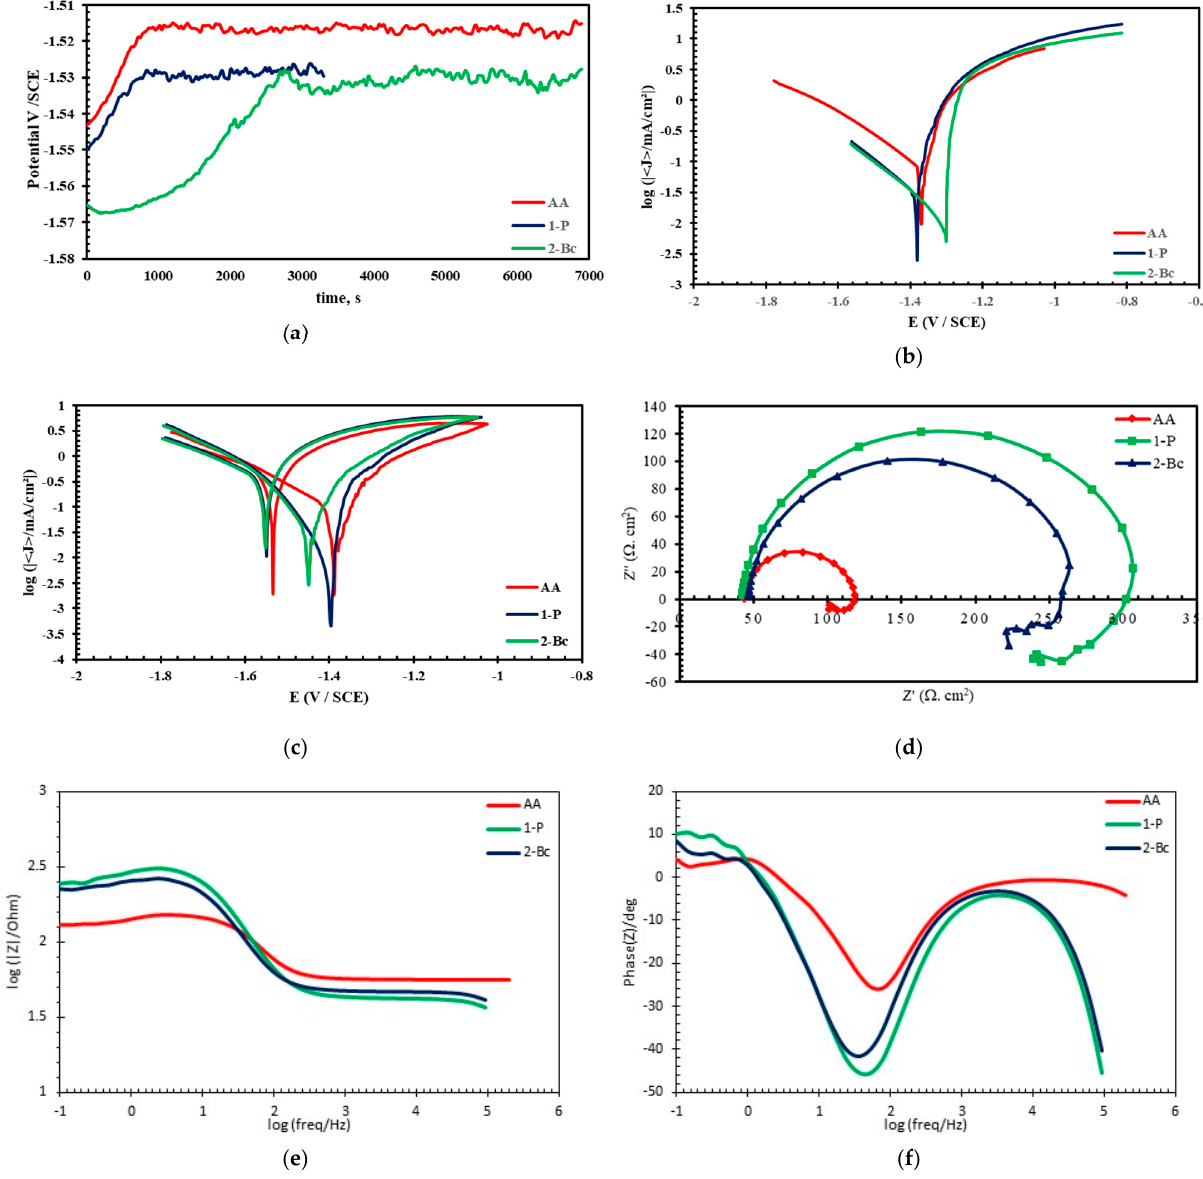
Figure 4. Corrosion measurements curves of AZ31 alloy processed through ECAP: ( a ) open circuit potential, ( b ) potentiodynamic polarization curves, ( c ) cyclic potentiodynamic polarization, ( d ) Nyquist plot, ( e ) electrochemical impedance diagrams (Bode plot), and ( f ) phase angle. Table 1. Electrochemical parameters obtained from potentiodynamic polarization curves of as- annealed condition (AA) and processed AZ31 Mg alloys.